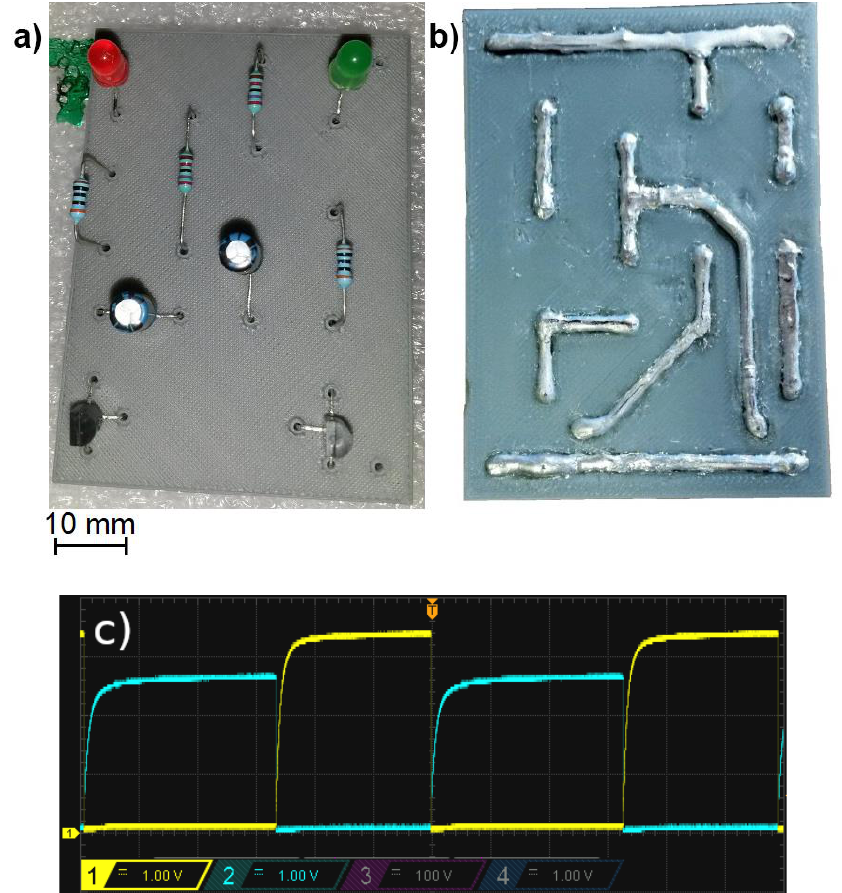
Figure 8. The 3D printed circuit after filling the grooves with Sn99Ag0.3Cu0.7 solder alloy: ( a ) top view ( b ) bottom view. ( c ) Output waveform for Q and Q ̅ outputs of the multivibrator.